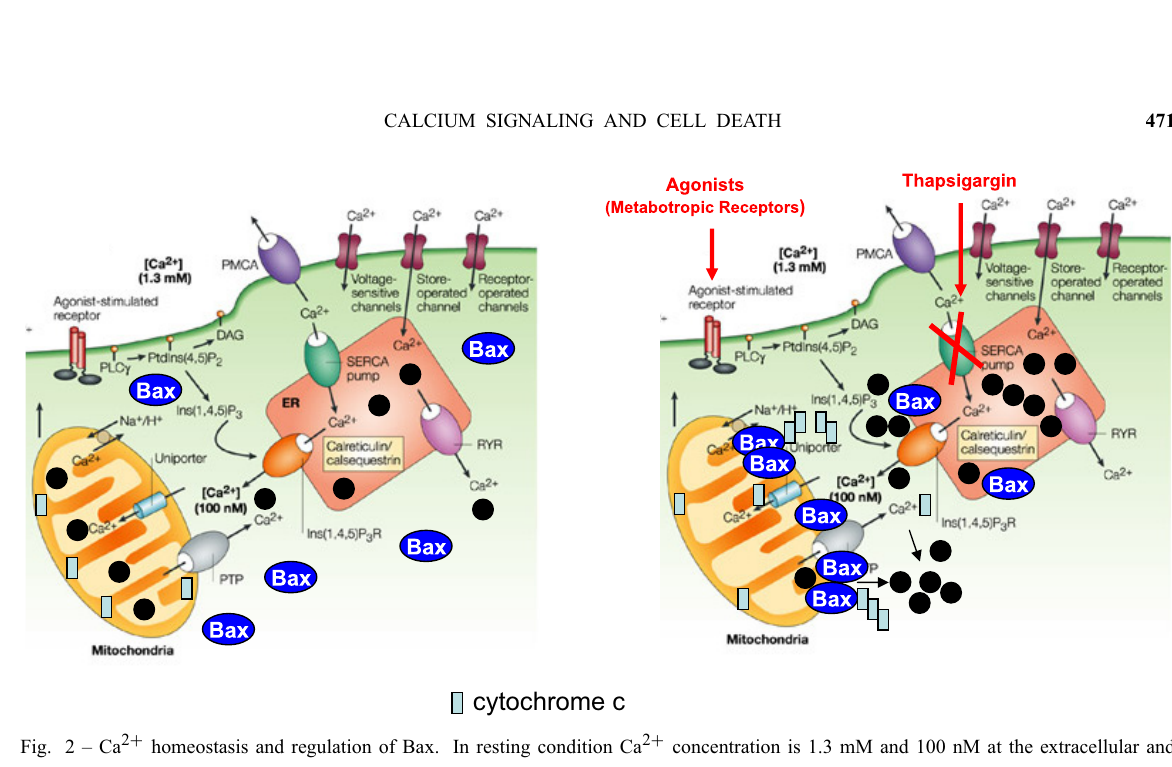
Fig. 2 – Ca 2 + homeostasis and regulation of Bax. In resting condition Ca 2 + concentration is 1.3 mM and 100 nM at the extracellular and intracellular spaces, respectively. When metabotropic receptors are stimulated Ca 2 + c is increased by the release of Ca 2 + from intracellular stores, such as ER and mitochondria. Transient increase in Ca 2 + c stimulates Ca 2 + uptake by mitochondria found in close proximity to ER. In regular conditions, mammalian cells express low level of Bax which is soluble in the cytosol. Under stress, cells overexpress pro-apoptotic proteins such as Bax which may translocate from cytosol to the mitochondrial membranes. At the mitochondrial level, Bax may oligomerize and form pores, interact with the PTP components or interact with other proteins for fission. The results are the release of cytochrome c and calcium to cytosol. Stimuli that mobilize Ca 2 + from intracellular stores (e.g. metabotropic receptor agonists or thapsigargin) may also induce Bax translocation and increase Bax toxicity. Once in the mitochondria, Bax leads to the permeabilization of mitochondrial membranes leading to the release of cytochrome c and other factors such as AIF, smacDIABLO which activate pro-caspases and down caspases that execute cell death. Bax can also release Ca 2 + m which may amplify cell death signals and accelerate apoptosis (Adapted from Orrenius et al. 2003 Nat Rev Mol Cell Biol 4: